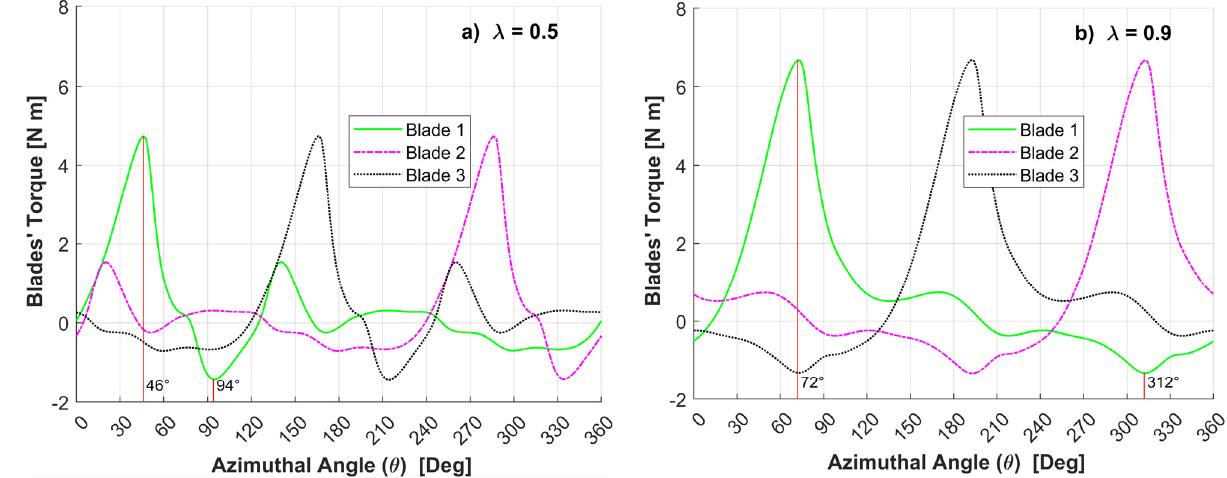
Figure 13. Torque on Blades 1, 2 and 3 at Various Azimuthal Angles, for U ∞ = 8 m/s at: ( a ) λ = 0.5 and ( b ) λ = 0.9, Using the 2D Model of the Present